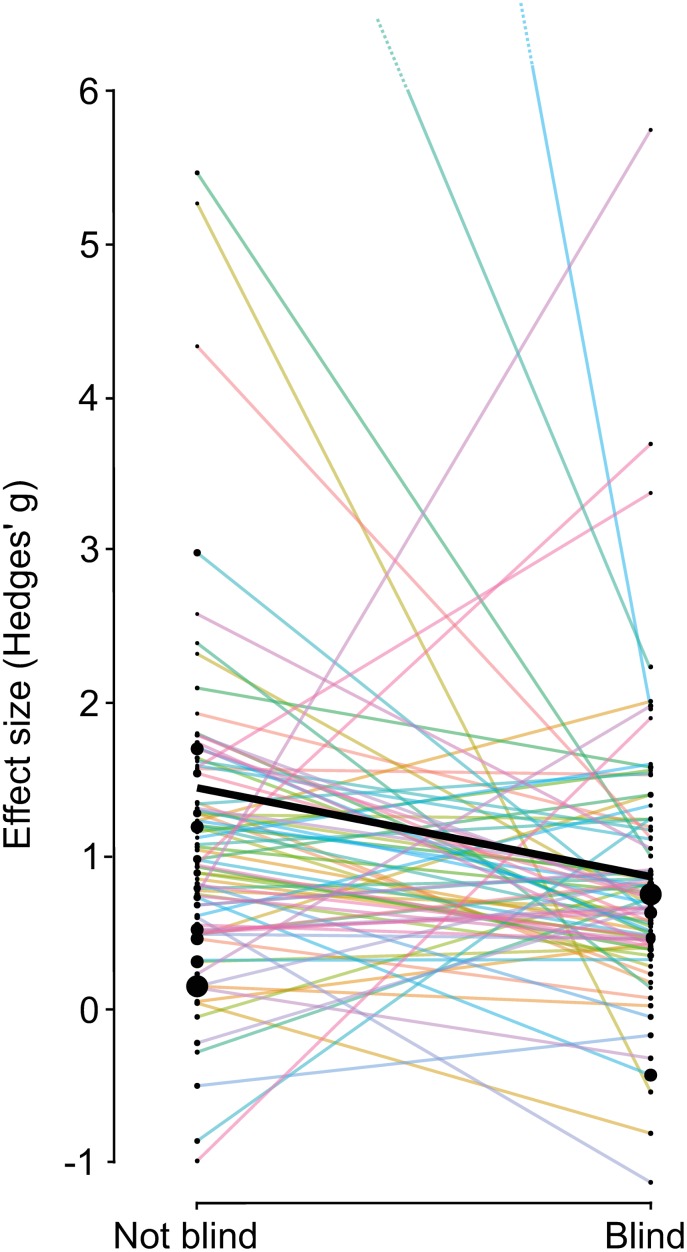
Nonblind studies had higher effect sizes than their paired blind studies, on average (n = 83 pairs).The thin lines show individual pairs, while the thick line shows the average effect size for each study type. The size of the dots is inversely proportional to the variance of the effect size, such that larger dots indicate more precise estimates. For clarity, two unusually large effect sizes are off the scale (dotted lines: g = 18.0 and 9.1).